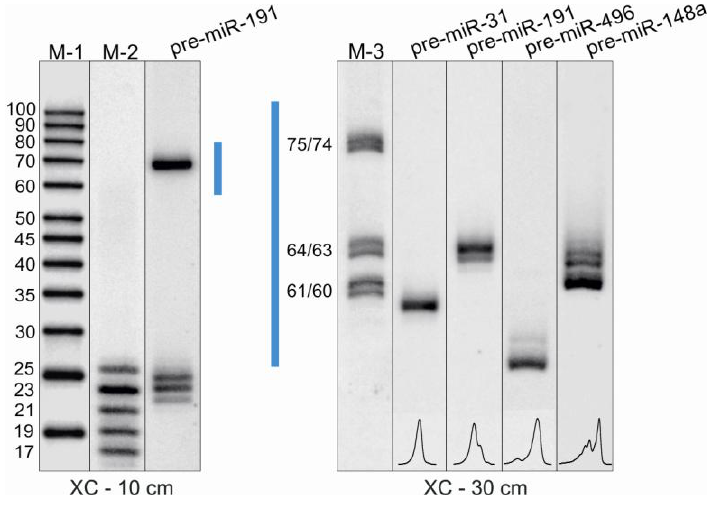
FIGURE 6. Anticipated resolution of pre-miRNA detection. Examples of pre-miRNAs detected with single-nucleotide resolution after short (A) and long (B) electrophoretic runs. The pre-miRNAs are indicated in the figure. M denotes the size markers; LMW RNA marker from USB (M-1), 17-, 19-, 21-, 23-, 25-nt ORNs (M-2), and 61/60-, 63/64-, 74/75-nt ORNs (M-3). The corresponding length ranges for the short and long electrophoretic runs are schematically marked as blue lines. Quantitative representations of pre-miRNA variants obtained from phosphorimaging analyses are also shown